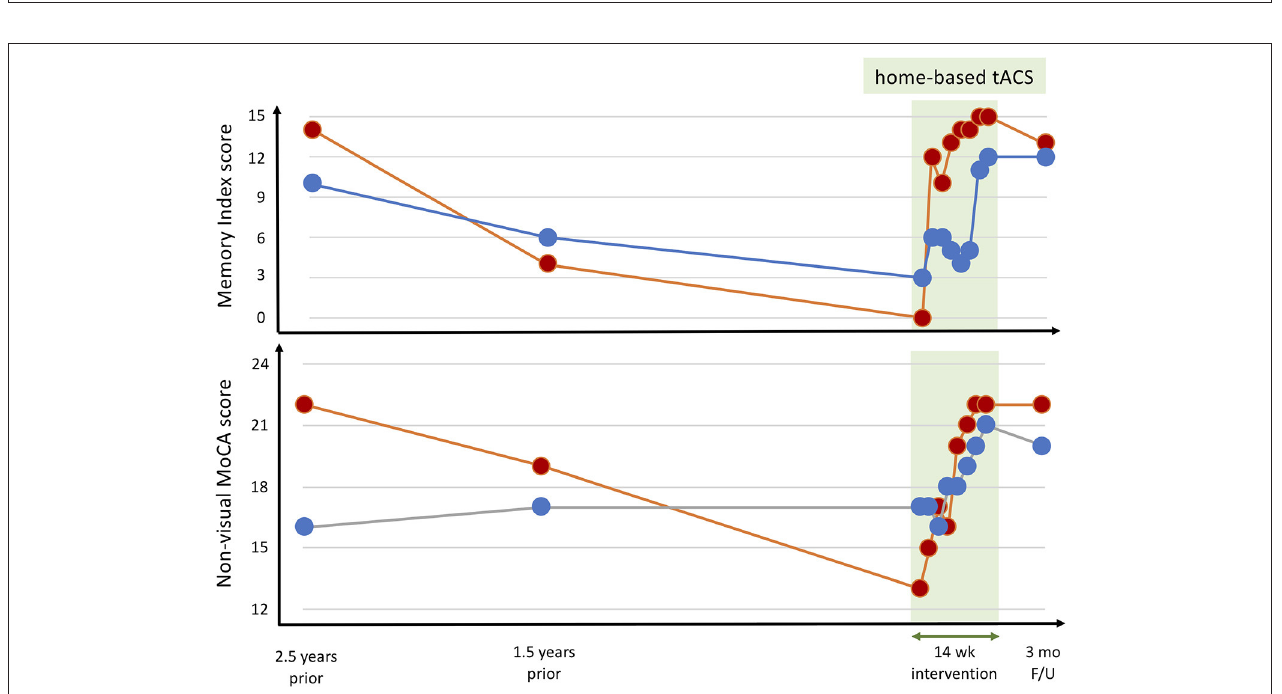
FIGURE 4 | Cognitive performance throughout a 14-week intervention of open-label, home-based, caregiver-administered tACS in two ADRD participants. Both participants completed all scheduled stimulation sessions and tolerated the intervention with no report of adverse events or complications. The Mini/5min non-visual versions of the Montreal Cognitive Assessment (MOCA) were evaluated via telehealth rotating between three different versions to avoid learning or carry-over effects. The equivalent metrics from the standard MOCA were extracted from the neuropsychological evaluations completed on both participants 2.5 and 1.5 years before study participation. By definition, the control subjects had normal memory index scores (a score of 14 or 15 in all cases) and normal MOCA scores (a score of 27–30 in all cases).